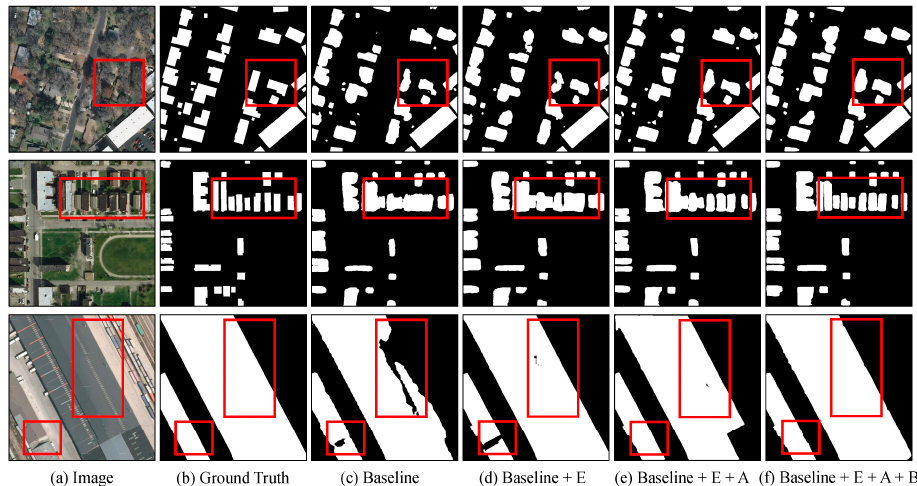
Figure 12. Ablation study results using the Inria dataset.